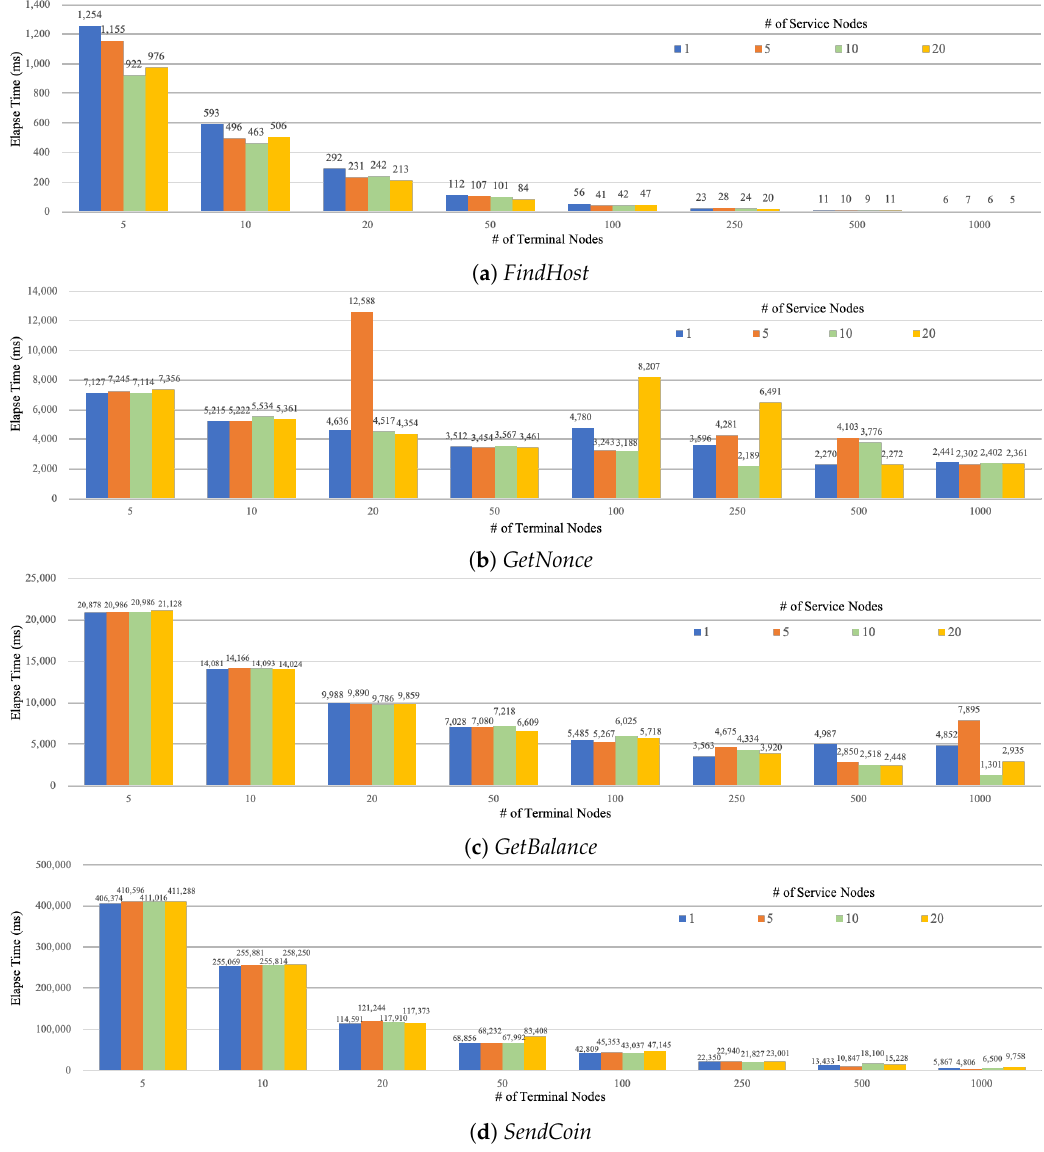
Figure 7. Average execution time over all topologies for four core functions: FindHost , GetNonce , GetBalance , and SendCoin . X-axis denote the number of Terminal Nodes (TNs), Y-axis is time in units of milliseconds, and the four colored bars represent the number of Service Nodes